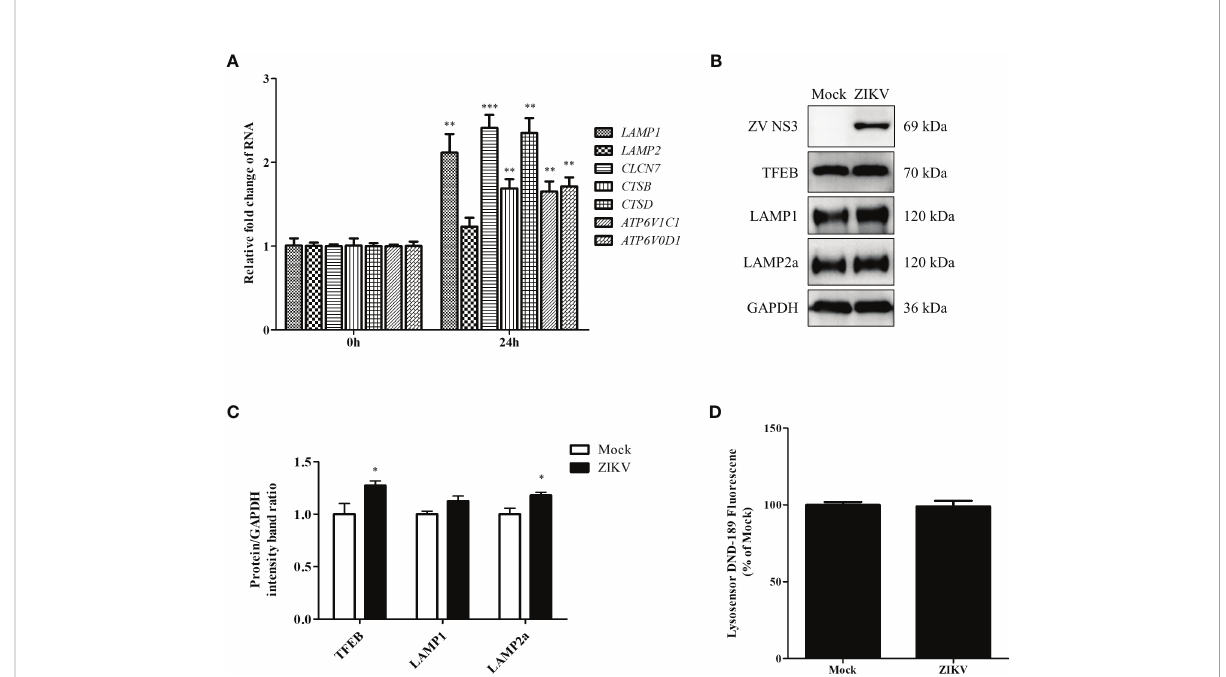
FIGURE 4 ZIKV infection promotes lysosomal biogenesis in Huh7 cells. Huh7 cells were infected with ZIKV at an MOI of 0.5 or mock-treated. Samples were collected at 24 h after ZIKV infection and subjected to qRT-PCR (A) or western blot analysis (B) . (A) The mRNA levels of lysosomal biosynthesis genes were examined. (B) Western blot analysis for TFEB, LAMP1, and LAMP2a levels. GAPDH was used as a loading control. (C) The intensity band ratios of TFEB, LAMP1, and LAMP2a to GAPDH were measured using densitometry. (D) The LysoSensor DND-189 fl uorescence intensity in Huh7 cells was measured 24 h after ZIKV infection. All the experiments were repeated at least three times. Data are presented as the mean ± SD from triplicates. * p < 0.05, ** p < 0.01, *** p <